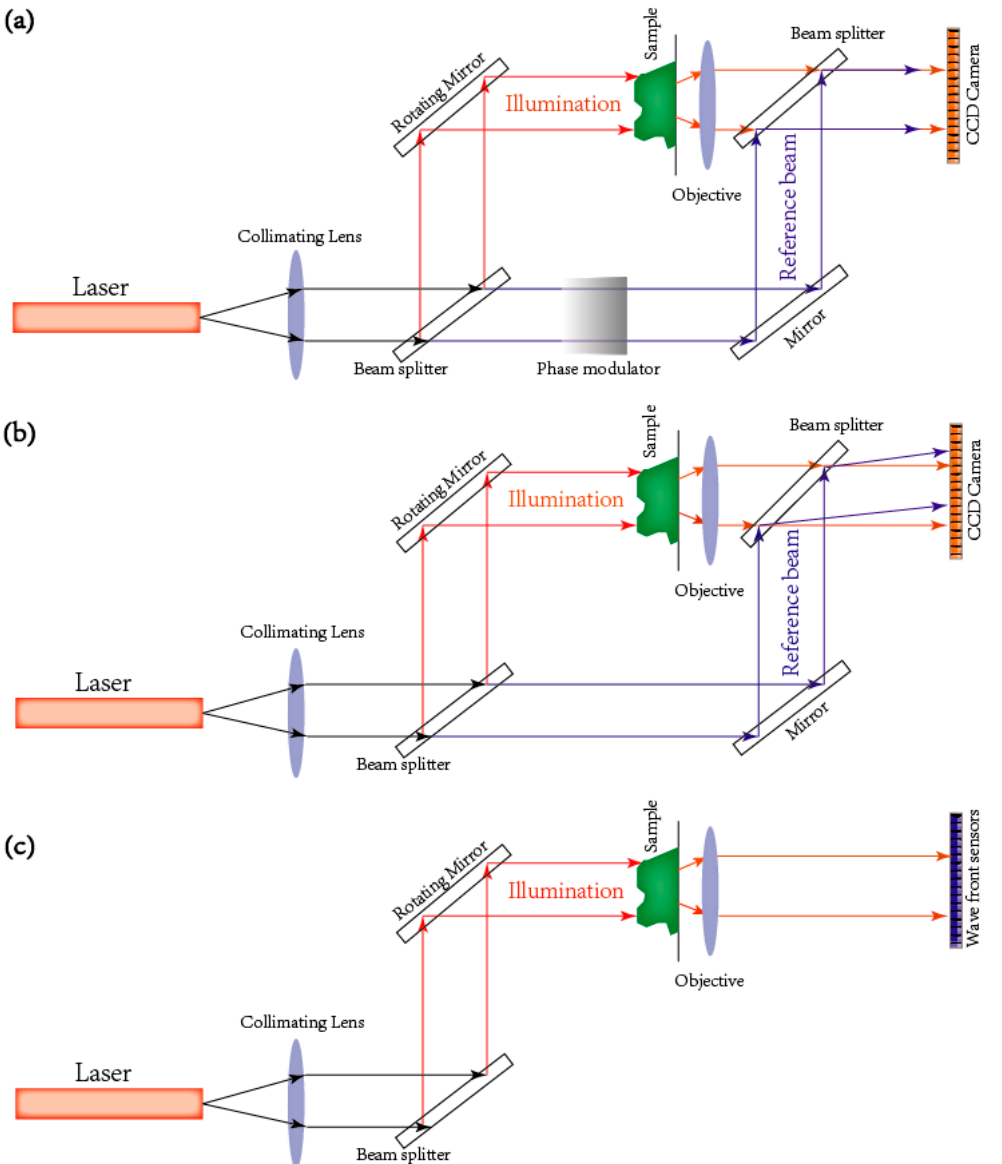
Figure 10. Schematic images of three different methods for complex diffracted field detection. ( a ) Phase shifting interferometry setup. ( b ) Off-axis interferometry setup. Compared to ( a ), the beam splitter at the right upper corner in ( b ) is rotated with a small angle so that the reference (blue) does not superimpose on the diffracted field (red). ( c ) Quadri-wave lateral shearing interferometry, wave front sensors setup.